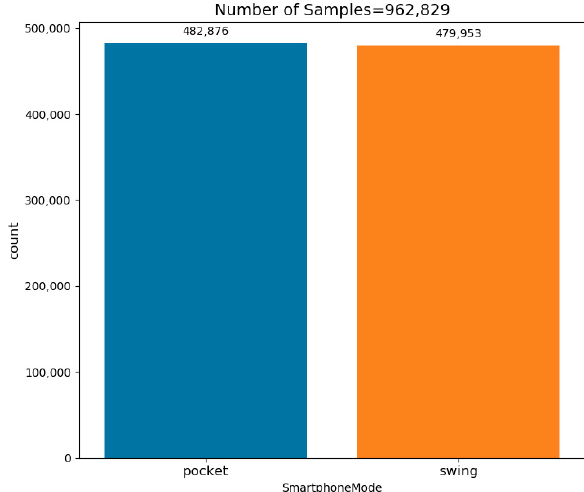
Figure A4. The WOB dataset’s sample distribution to each smartphone location.